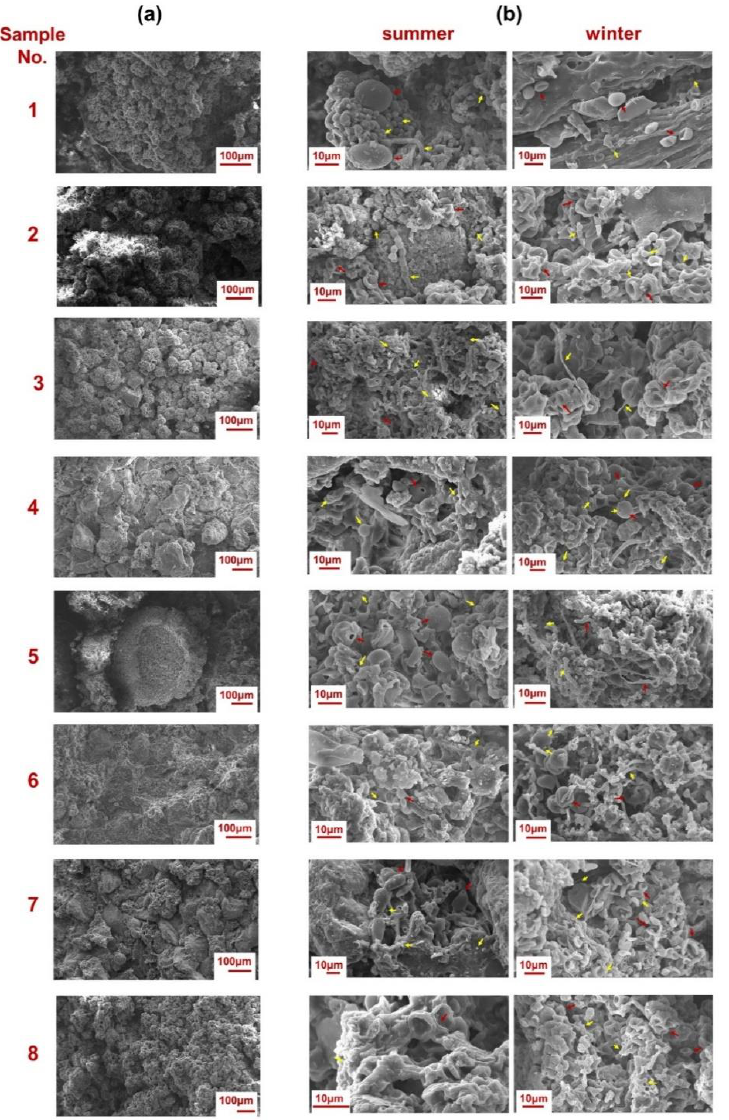
Figure 3. Scanning Electron Microscopy (SEM) images of lithobiontic organisms (red arrows) and of microorganisms (yellow arrows) inhabiting historical Pergola. SEM images of larger biofilm areas ( a ) and SEM images at higher magnification for biofilms samples analyzed in summer and winter ( b ).